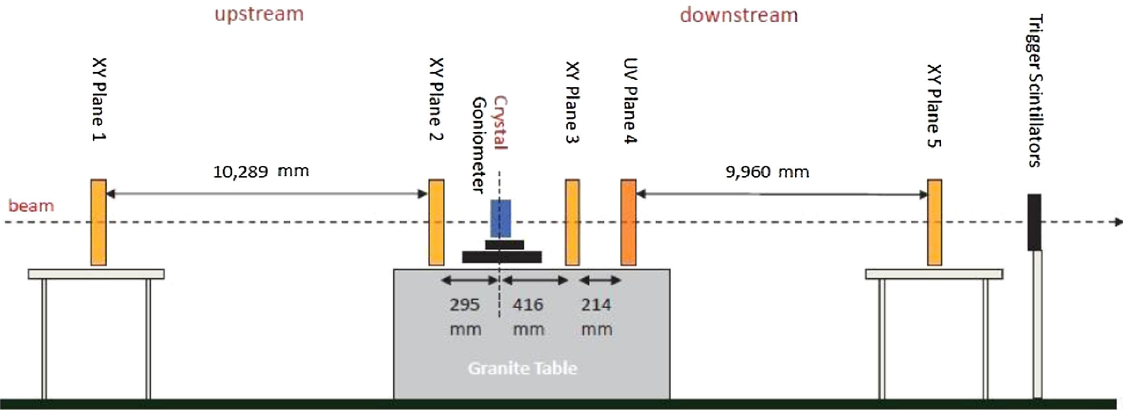
FIG. 3. A schematic view of the layout of the experiment. XY Plane 1 – 5 are the silicon strip detectors. The bent crystal mounted at the goniometer is installed between strip detectors 2 and